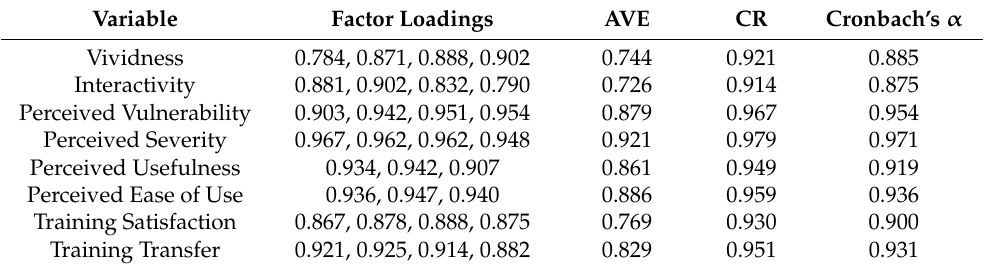
Table 3. Convergent Validity.